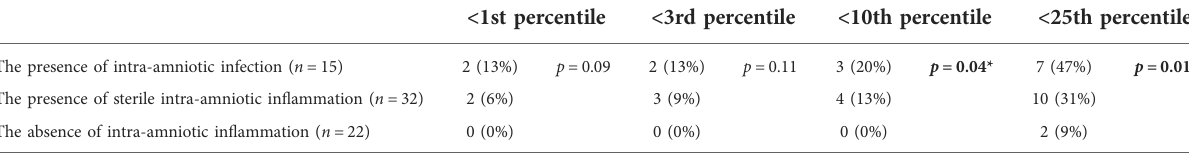
TABLE 2 The rate of newborns with birth weights, expressed as percentiles derived from estimated fetal weight standards, that were less than or equal to the 1st, 3rd, 10th, and 25th percentiles from pregnancies with preterm labor with intact membranes prior to a gestational age of 35 weeks with the presence of intra-amniotic infection, presence of sterile intra-amniotic in fl ammation, and absence of intra-amniotic in fl ammation. <1st percentile <3rd percentile <10th percentile <25th percentile The presence of intra-amniotic infection ( n =15) 2 (13%) p =0.09 2 (13%) p =0.11 3 (20%) p =0.04* 7 (47%) p =0.01* The presence of sterile intra-amniotic in fl ammation ( n =32) 2 (6%) 3 (9%) 4 (13%) 10 (31%) The absence of intra-amniotic in fl ammation ( n =22) 0 (0%) 0 (0%) 0 (0%) 2 (9%) Variables are presented as number (%) and were compared using Cochran-Armitage test for trend. Statistically signi fi cant results are marked in bold.